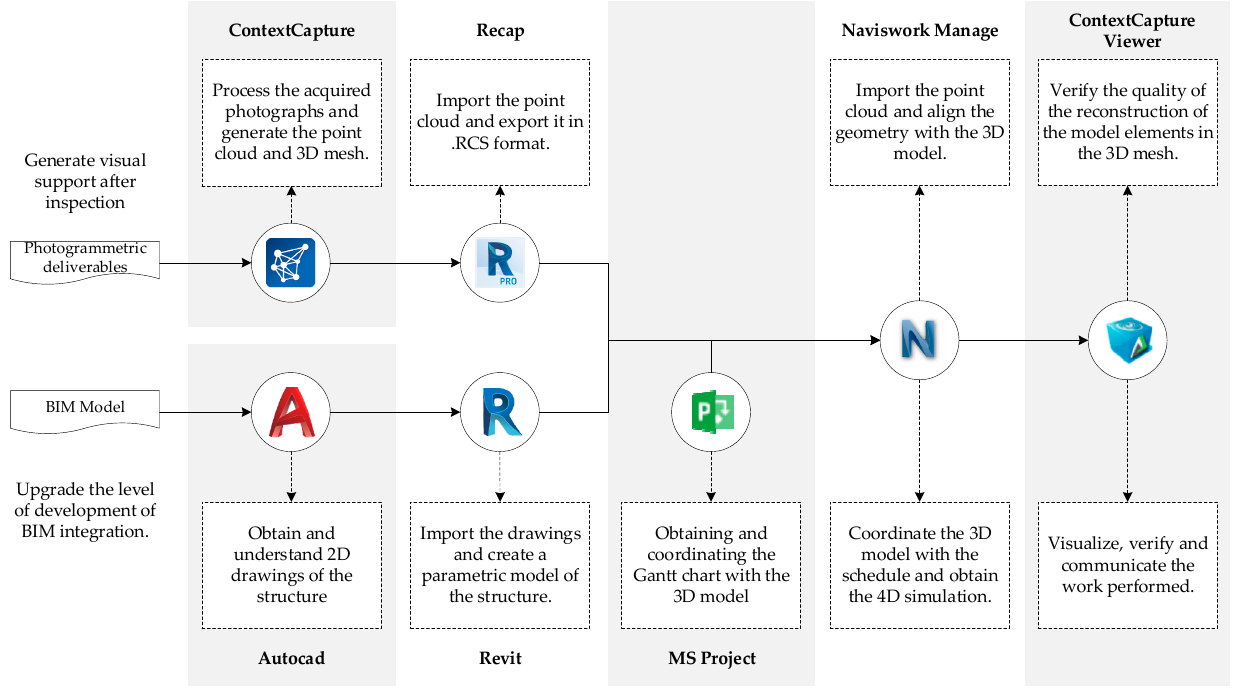
Figure 4. Tools used in the application of the methodology to the case study.